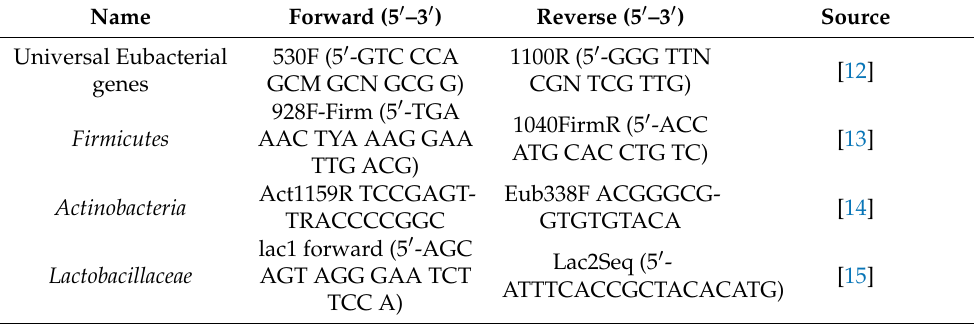
Table 4. Primers used during